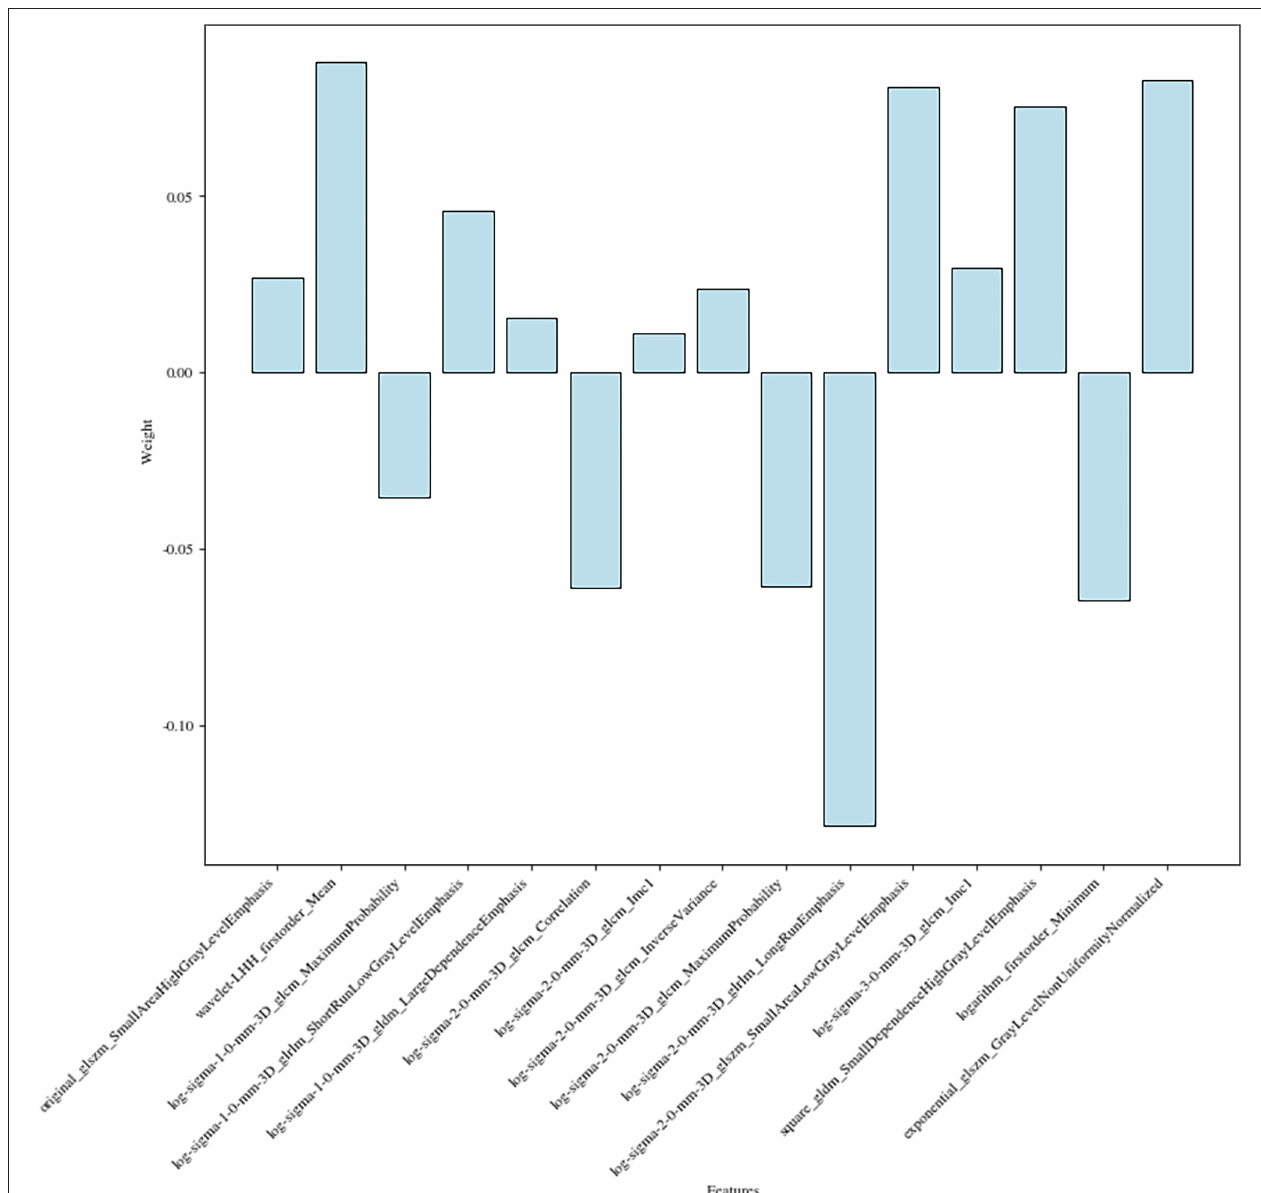
FIGURE 4 | Radiomic features related to WT staging and their